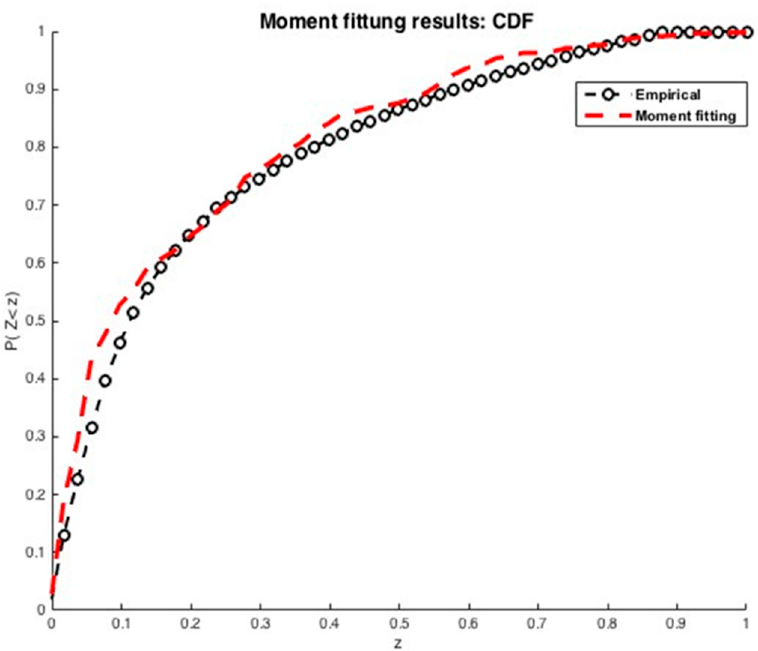
Figure 15. Estimation of the cumulative density function of the number of deaths by SARS-CoV-2 in Morocco. The results furnished by moment matching method.